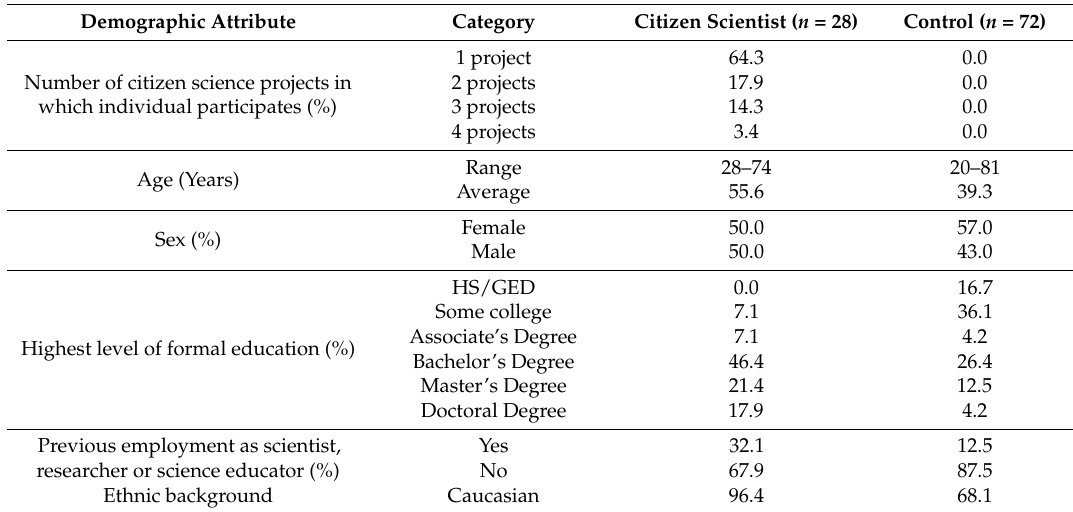
Table 3. Demographic data of treatment and control group participants.